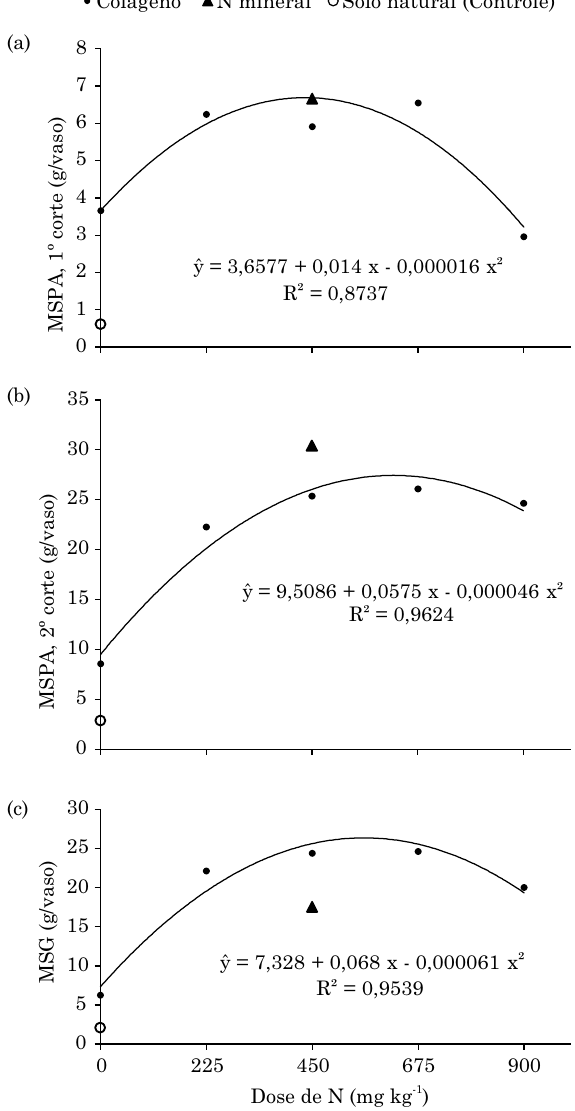
Figura 1. produção de matéria seca de parte aérea (mspa) no 1º corte (a) e no 2º corte (b) e nos grãos (msg) (c) em plantas de trigo submetidas a doses de nitrogênio via colágeno de curtume e dois tratamentos adicionais, cultivadas em Latossolo Vermelho Distrófico